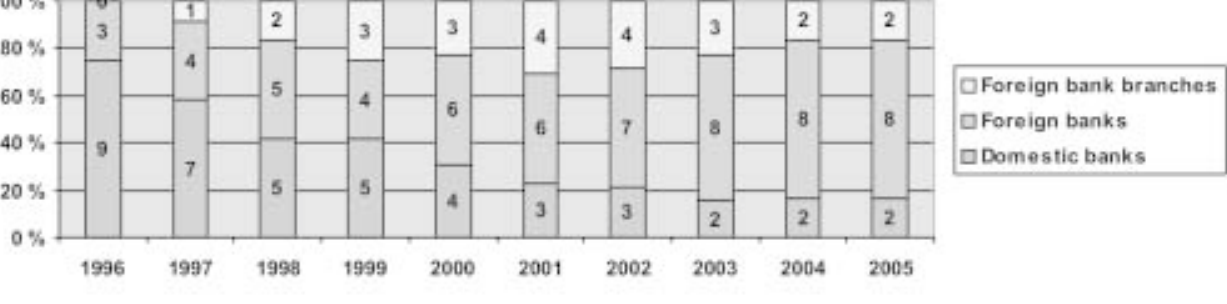
Fig 1 . Number of local and foreign market